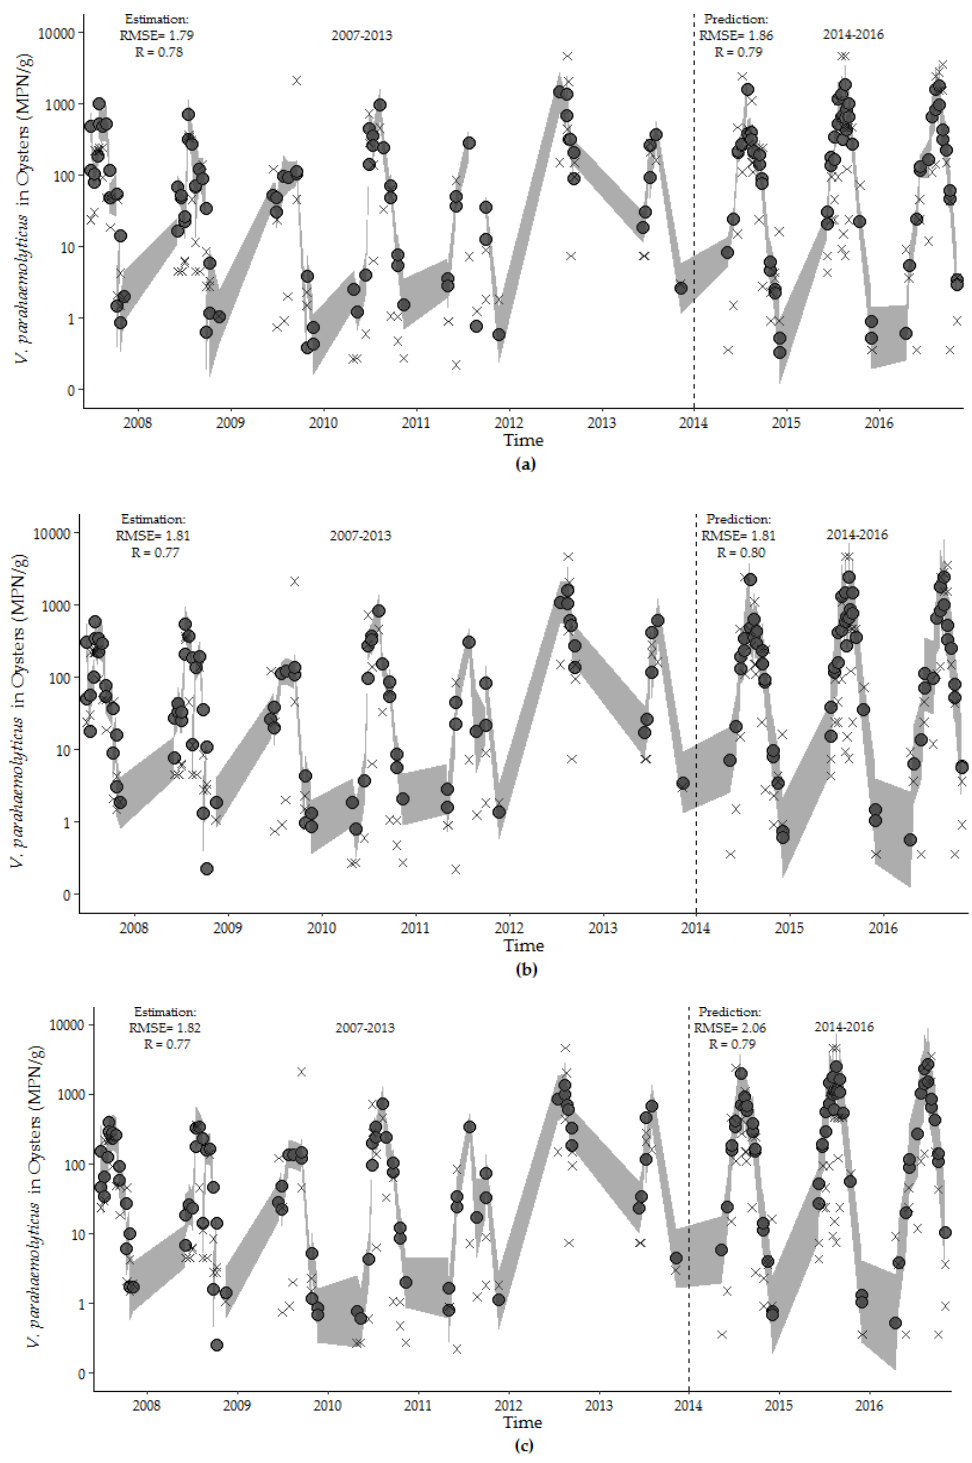
Figure 8. Estimates of V. parahaemolyticus concentrations (closed circle) with observed V. parahaemolyticus concentrations for: ( a ) environmental model, ( b ) hybrid model, and ( c ) harmonic regression model for the training (2007–2013) and test (2014–2016) periods. The 95th percentile prediction interval is represented by the gray shading. Model fit values are shown in the upper left corner of each figure.